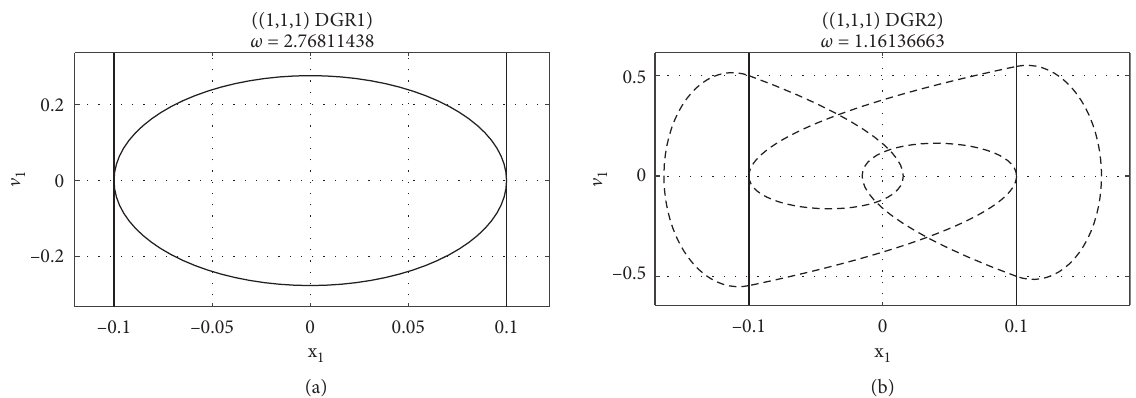
Figure 3: (a) The phase diagram at the double grazing bifurcation point DGR1 of the period-1 orbit detected at ω ≈ 2 . 76811438. (b) The phase diagram at the double grazing bifurcation point DGR2 of the period-1 orbit detected at ω ≈ 1 . 16136663.